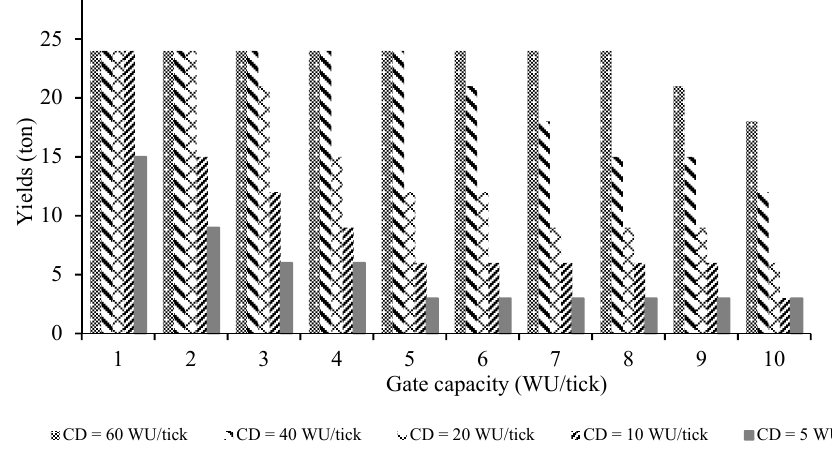
Figure 6. The yields of RC1 and LC1 with insufficient water under Demand Control.